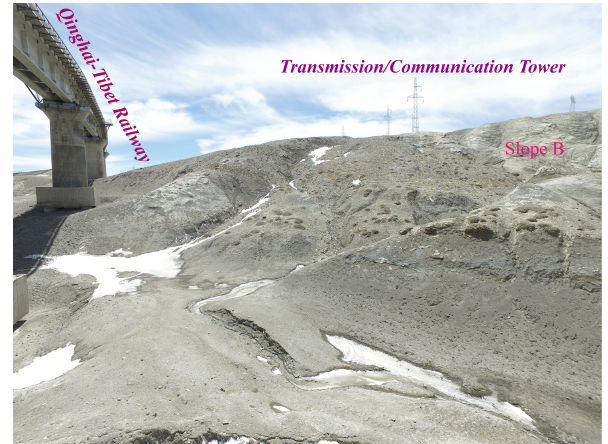
Figure D2. Slope B. The railways and power and communication towers are clearly visible.